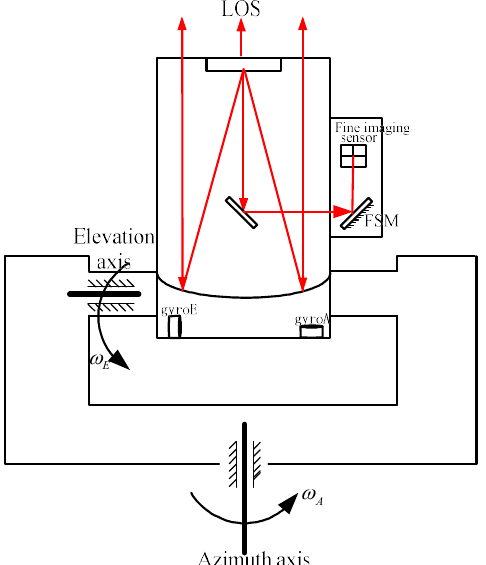
Figure 1. The schematic of electro-optical tracking system (EOTS) A  is the velocity of azimuth axis; ω E is the velocity of elevation  is the velocity of elevation axis. E